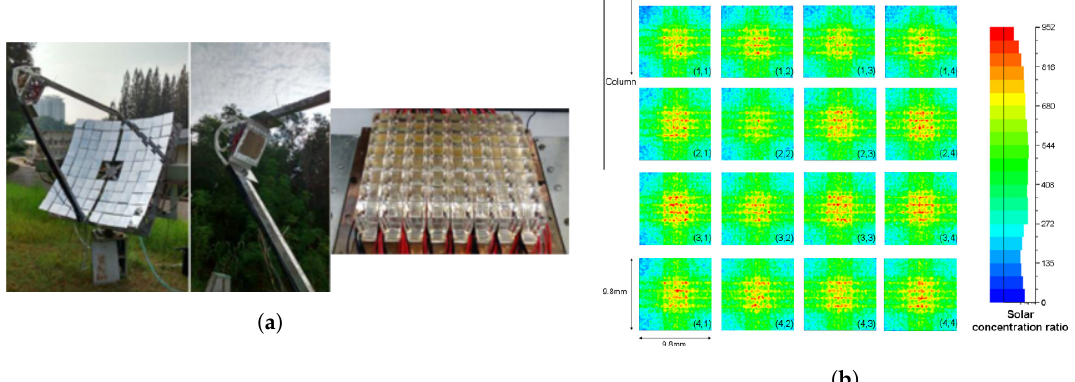
Figure 35. Concentrator photovoltaic system consisting of a parabolic mirror as a primary optic and a set of crossed compound parabolic concentrators with a rectangular section as a secondary optic